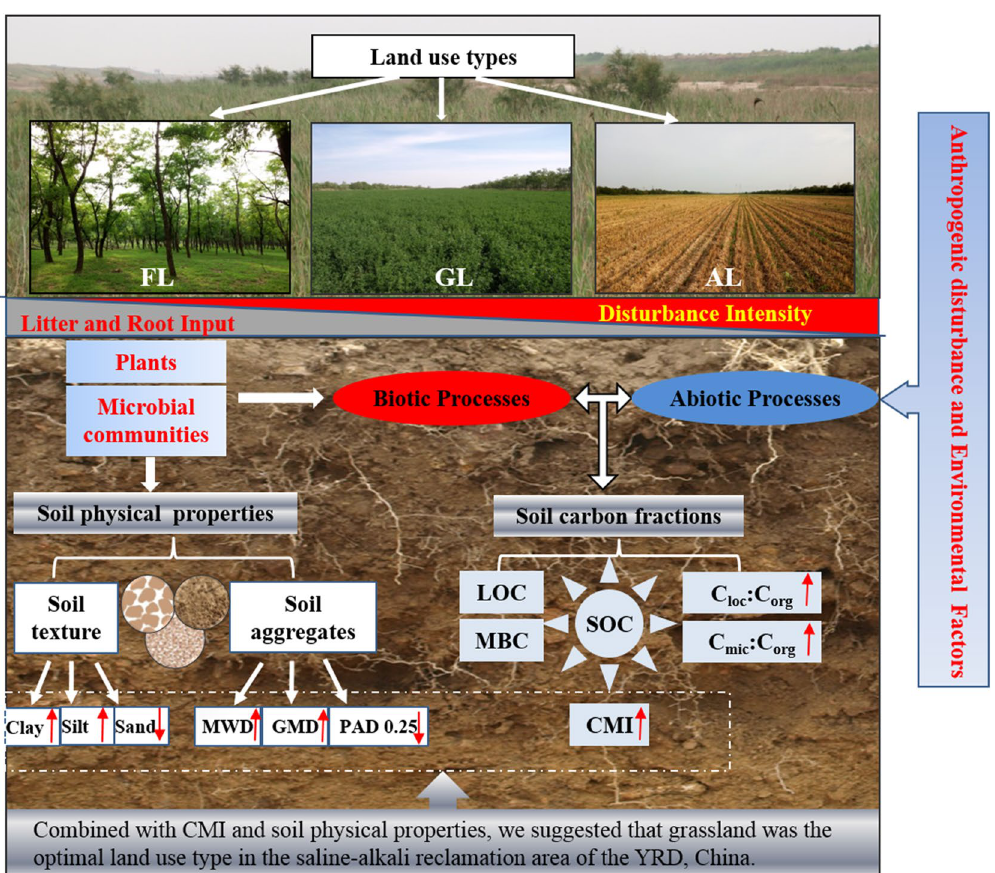
Figure 5. Relationship between soil physical properties and soil organic carbon with different land uses. The photographs in Fig. 5 were taken from three land uses (FL, GL, AL) in the study area by the author ‘Shuying